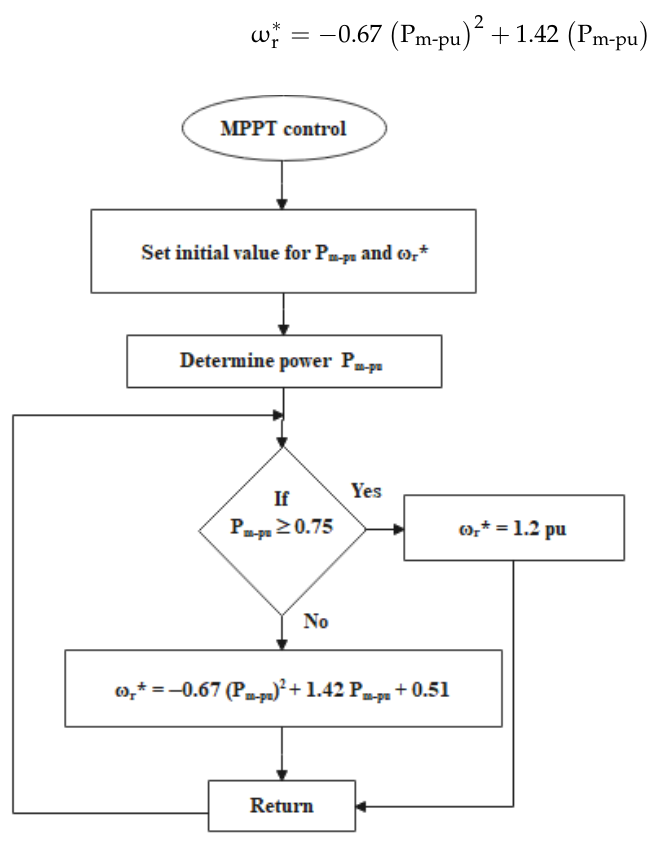
Figure 12. Proposed flow chart of the MPPT.